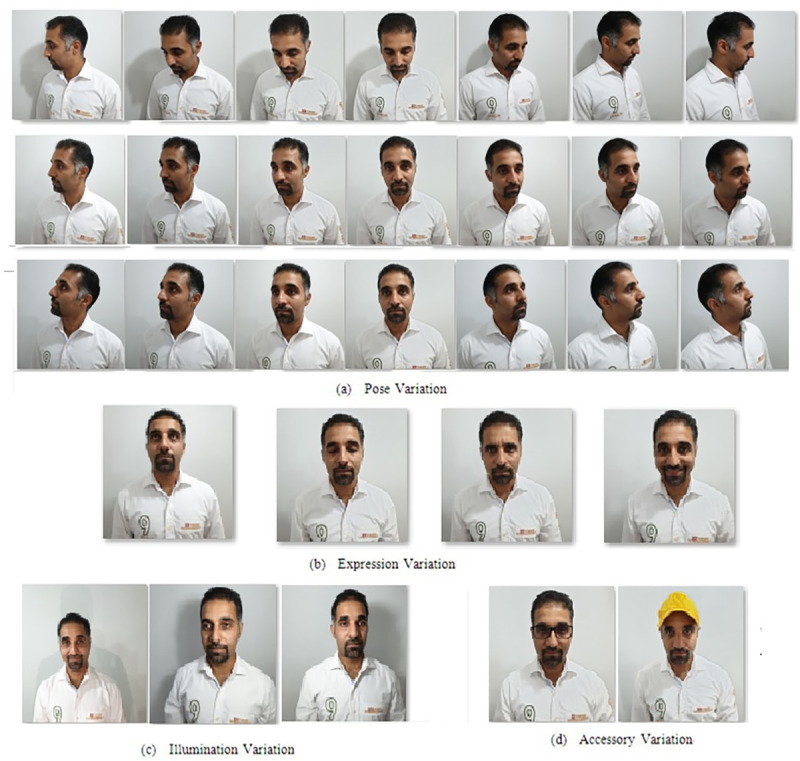
Face images of SDUMLA-HMT subjects under different conditions as a dataset example [18].